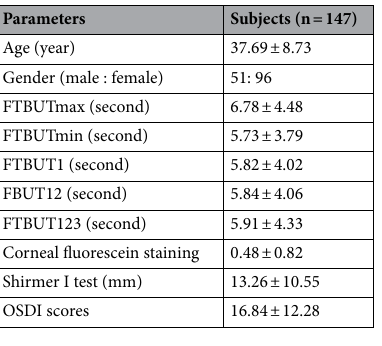
Table 1. Demographics of all participants: descriptive statistics. Subjects were shown as mean ± standard deviation.